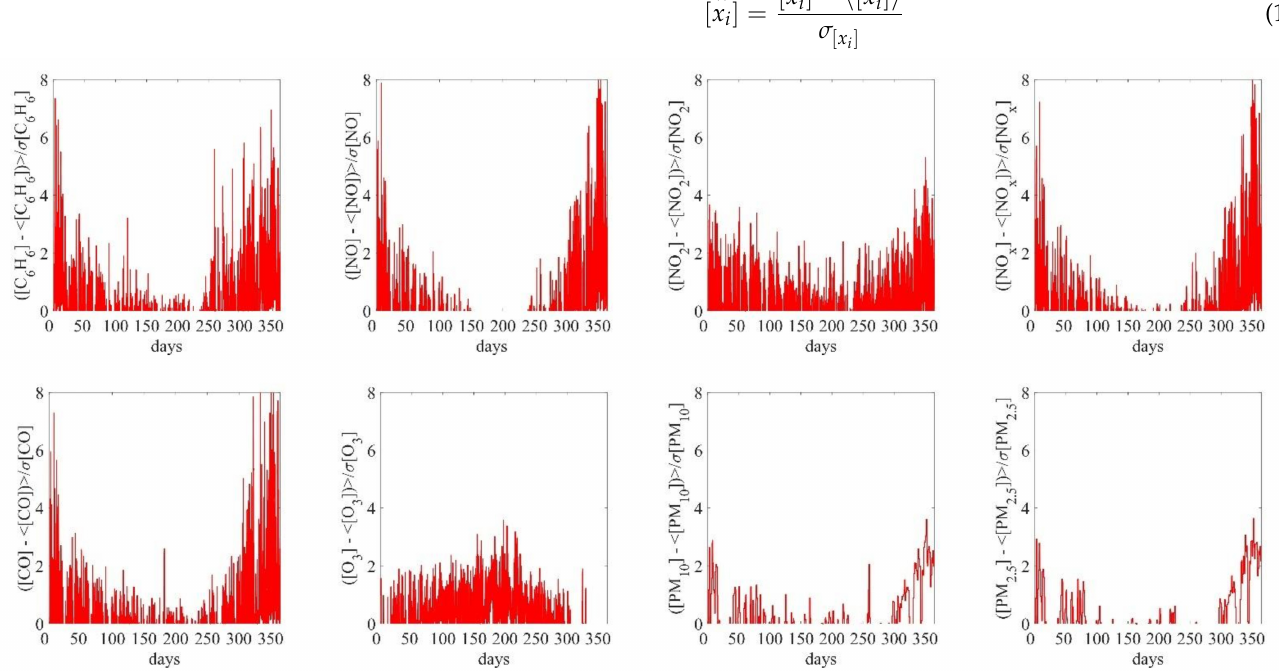
Figure 3. Normalized pollutant concentrations of Rome in 2015. Values are referred to the subtraction of the pollutant concentration in time by time with the mean values in spring, summer, and autumn in order to decurtate the pollutant level from the urban traffic